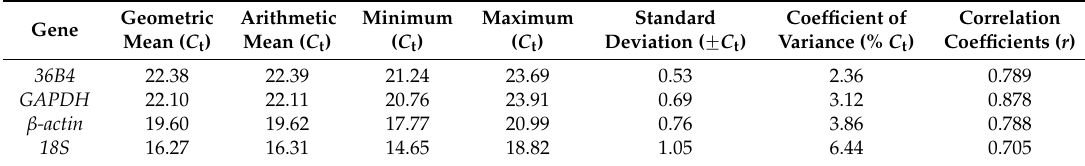
Table 1. Expression stability of four reference gene in epididymal white adipose tissue (eWAT) evaluated by BestKeeper ( n = 12).